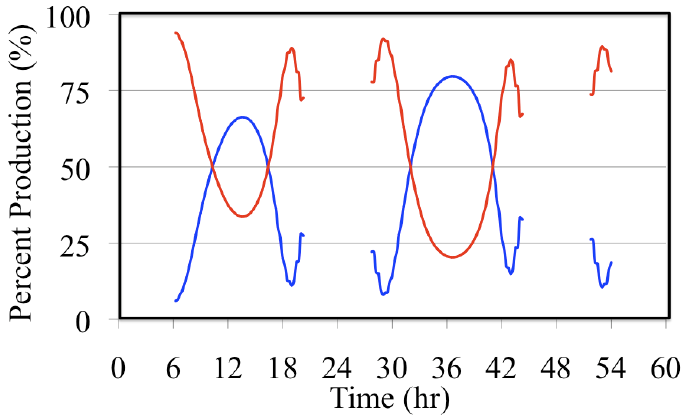
Figure 18. Daytime relative production rates of HO • resulting from the photolysis of formaldehyde (red line) and the photolysis of O urban atmosphere